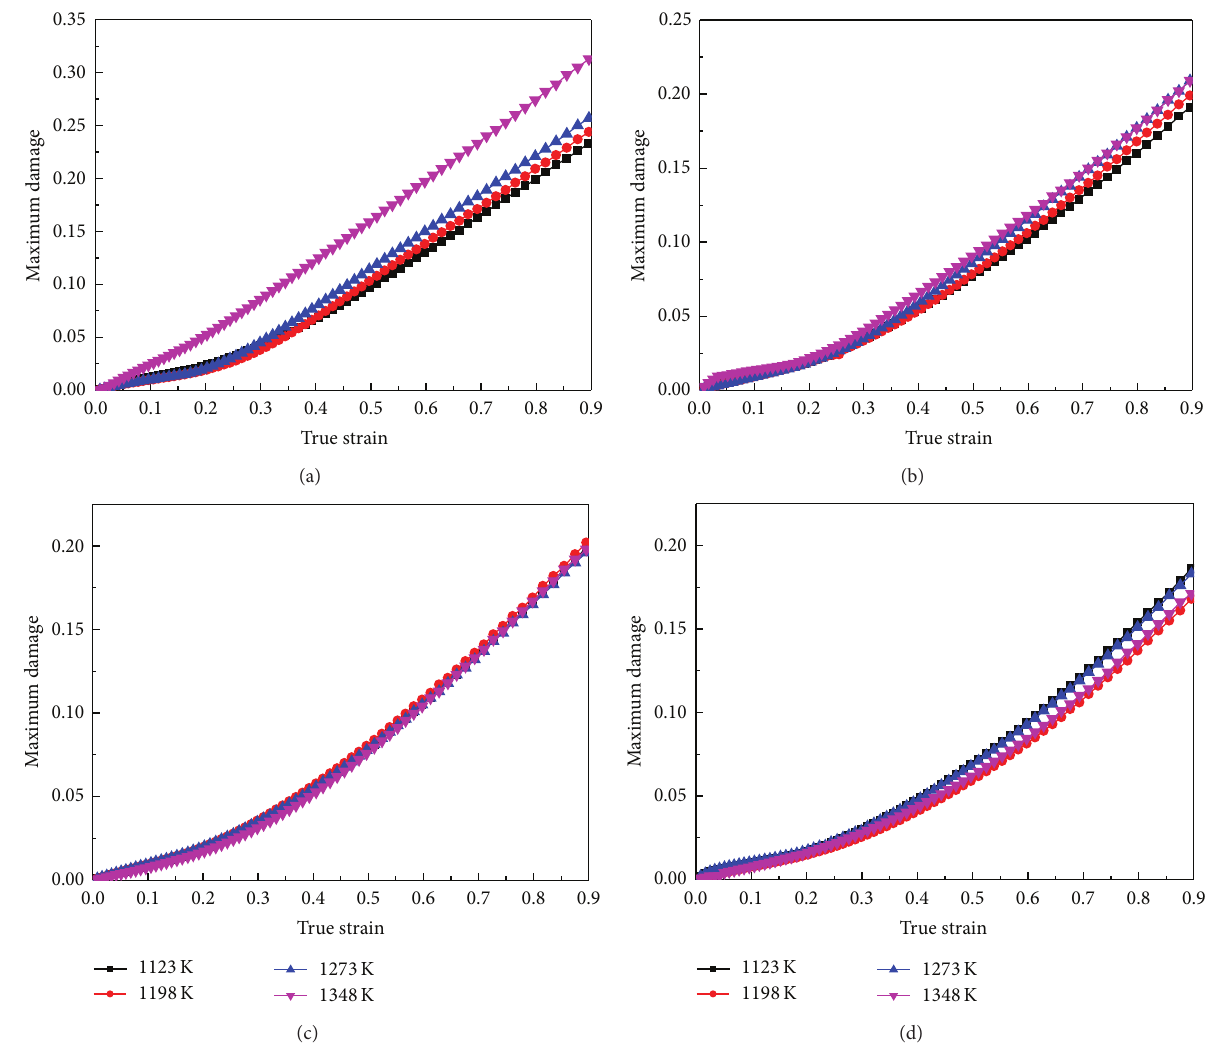
Figure 5: The maximum damage varying during compressing process at different temperatures and strain rates: (a) 0.01 s −1 , 1123 ∼ 1348K; (b) 0.1s −1 , 1123 ∼ 1348K; (c) 1s −1 , 1123 ∼ 1348K; (d) 10s −1 , 1123 ∼